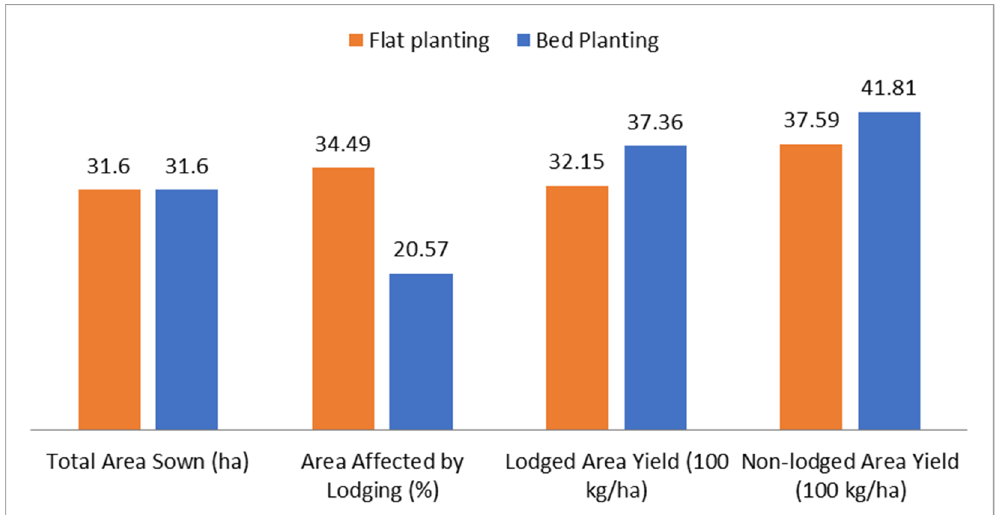
Figure 3. Benefits of raised bed planting to provide resistance against lodging.